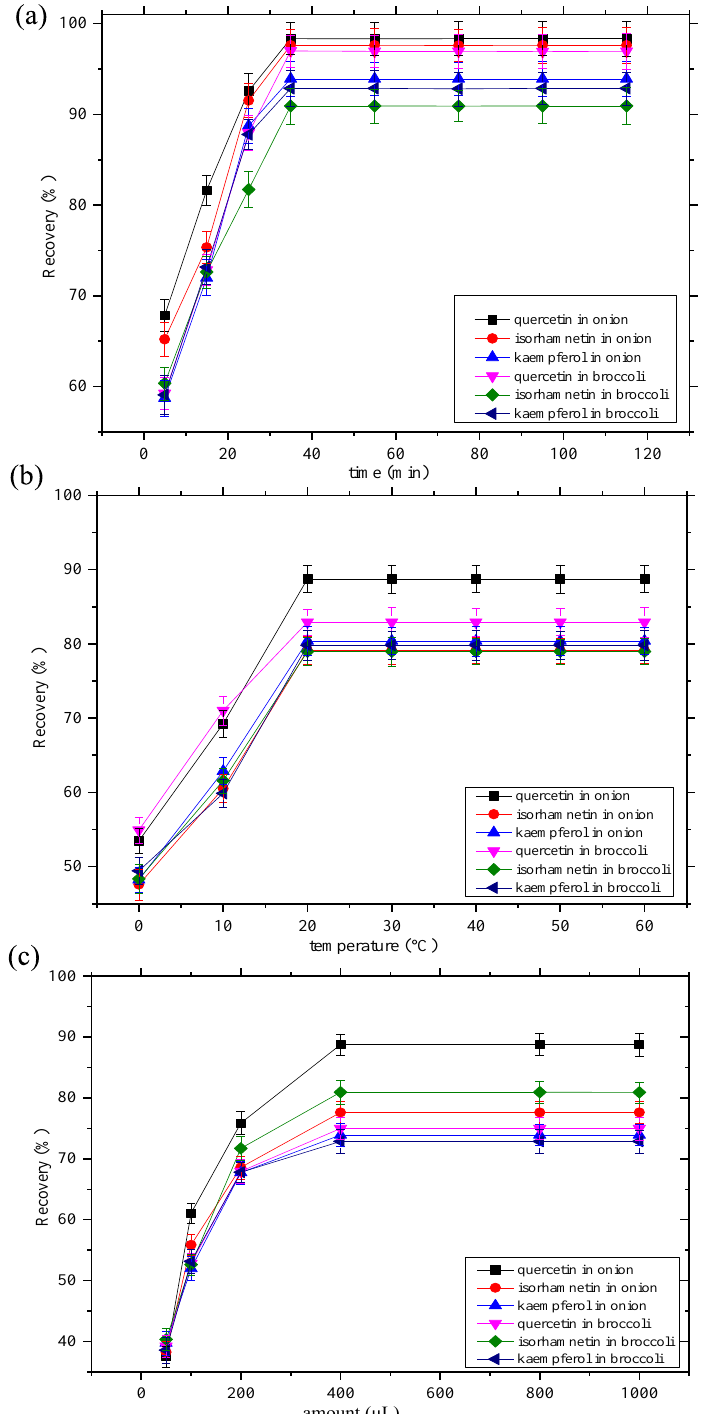
Figure 5. Optimization of the extraction conditions. a : effects of extraction time, b : effects of temperature, and c : effects of amount of NADESs added.